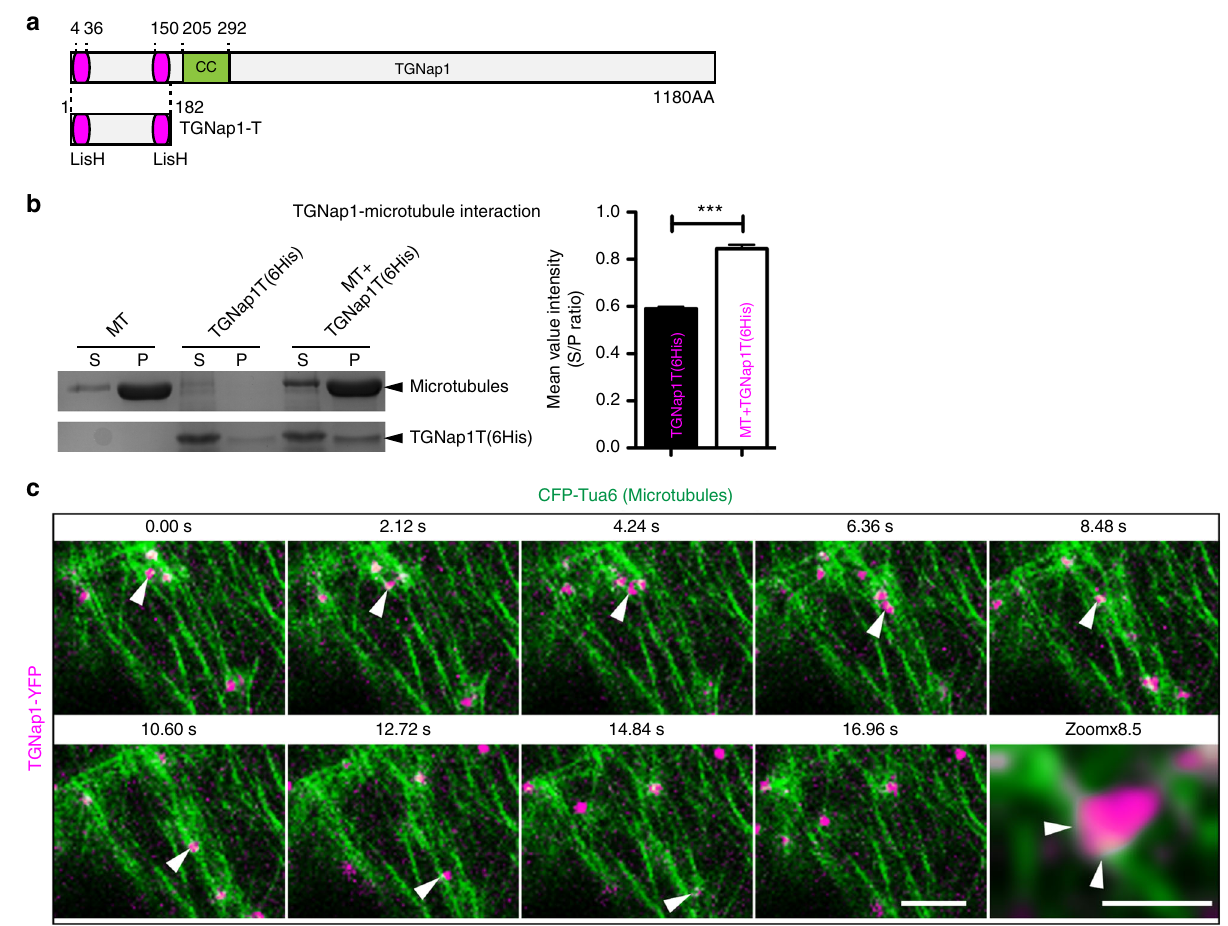
Fig. 6 TGNap1 is a MT-binding protein. a TGNap1 protein domains showing LisH and coiled coil (CC) domains. Numbers indicate domain positions and total protein length (AA: amino acid residues). TGNap1-T indicates the LisH domain-containing region used for the interaction assay presented in b . b MT sedimentation assay with recombinant TGNap1T-His and bovine brain MT showing that TGNap1 is in supernatant in the absence of MT (S), and precipitates in the pellet (P) in the presence of MT. The graph represents the soluble/ pellet ratio of the mean three measurements value for TGNap1 protein band intensity. c Images extracted from confocal microscopy time-lapse (see Supplementary Movie 1) acquired on cotyledon epidermal cells coexpressing TGNap1-YFP (magenta) and CFP-Tua6 (green). Arrowheads point to one TGN that was tracked overtime showing a continuous association with MT. Zoomed image shows a close-up of the same TGN; arrowheads indicate points of contact of the TGN with MT. Scale bars = 5 µ m (main images); 1 µ m in zoomed image. Student t -test was applied, p -values are represented by asterisks when signi fi cantly different from the corresponding control: *** p < 0.001; **0.001 > p < 0.01; n.s., not signi fi cant. Source data is provided as a Source Data fi